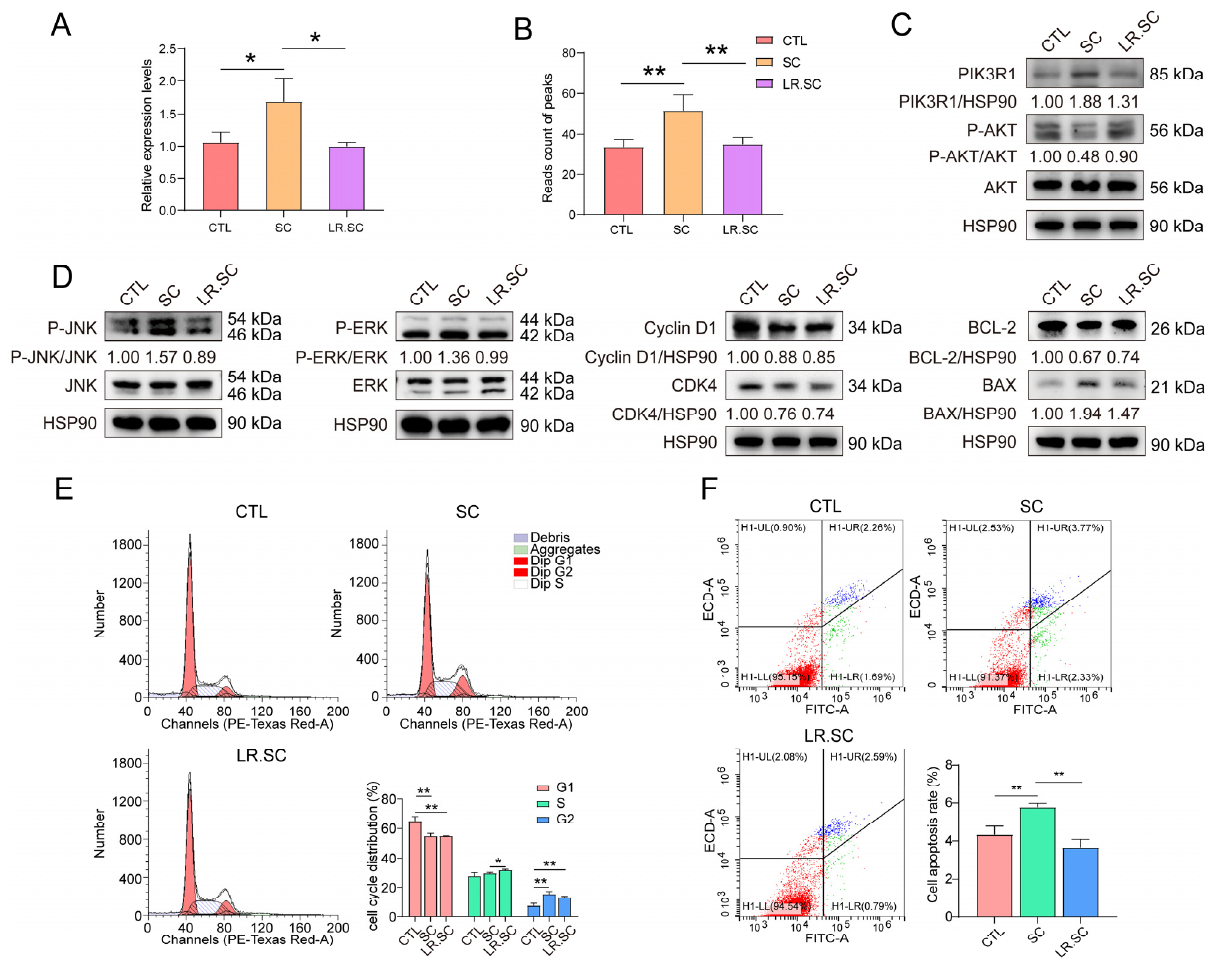
Figure 6. Detection of PI3K/AKT pathway, cell cycle, and apoptosis in IPEC-J2 cells treated with S. enterica BNCC186354 and L. reuteri ATCC 53,608 for 4 h. ( A ). PIK3R1 expression was detected via qRT-PCR among different groups. ( B ). Read counts of PIK3R1 peaks among different groups from the ATAC-seq dataset. ( C ). PIK3R1 protein expression and the phosphorylation level of AKT, detected by performing Western blotting. ( D ). Western blotting was performed to detect the phosphorylation level of JNK1 and ERK1 and the expression of Cyclin D1, CDK4, BCL-2, and BAX. All Western blot images were normalized, the phosphorylated proteins were divided by corresponding total protein, and other proteins were divided by HSP90; the control was equal to 1. ( E ). Distribution of cell cycle in IPEC-J2 cells treated with S. enterica BNCC186354 and L. reuteri ATCC 53608. ( F ). Effect of S. enterica BNCC186354 and L. reuteri ATCC 53,608 treatment on apoptosis in IPEC-J2 cells. *, p <0.05; **, p